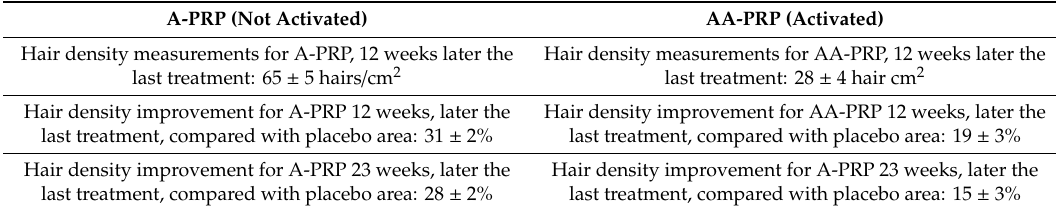
Table 2. Clinical results obtained using A-PRP versus